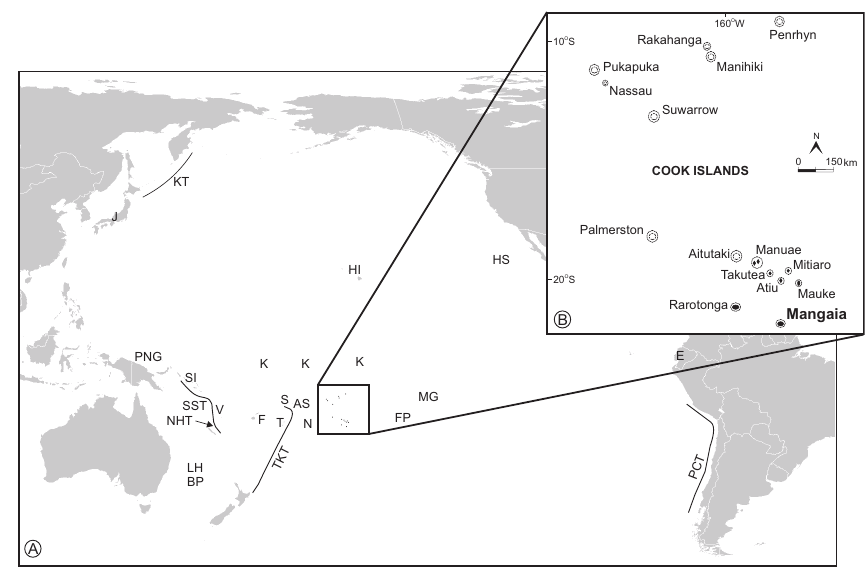
Fig. 1. (A) Map of the Pacific Ocean showing names of islands and features discussed in the text (AS: American Samoa inc Ta’u, Ofu, Olosega; E: Ecuador; F: Fiji; FP: French Polynesia inc. Tahiti, Moorea, Bora Bora; HI: Hawaiian Islands; HS: Henderson Seamount; J: Japan; K: Kiribati; KT: Kuril trench; LHBP: Lord Howe, Balls Pyramid; MG: Marquesas Group; N: Niue; NHT: New Hebrides